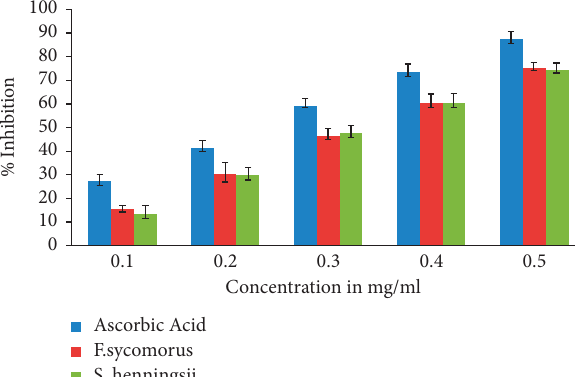
Figure 1: Percentage hydrogen peroxide inhibition of the DCM leaf extract of S. henningsii , the stem bark extract of F. sycomorus , and the standard ascorbic acid. Values are expressed as mean ± SEM of the three replicates. Column means followed by the same superscript letters were not signifcantly diferent ( p > 0 . 05) by one-way ANOVA followed by Tukey’s post hoc test.